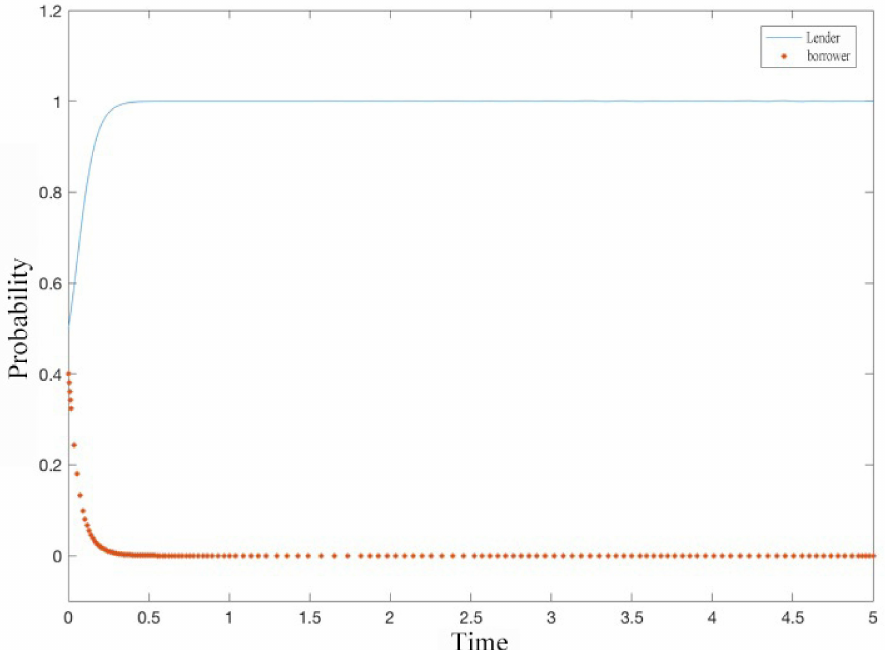
Figure 7. The dynamic evolutionary processes of the active online lending platform with small penalties for defaulting.